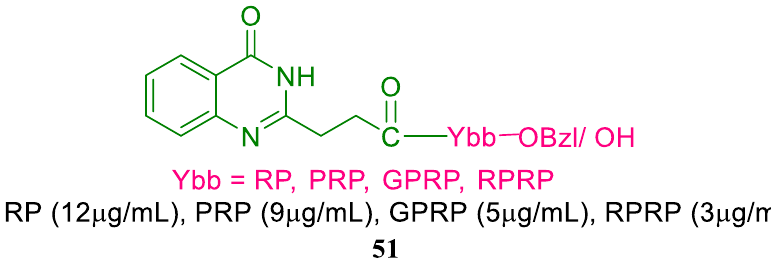
Figure 46. Quinazolinone conjugated to shorter analogues of Bactenecin 7.